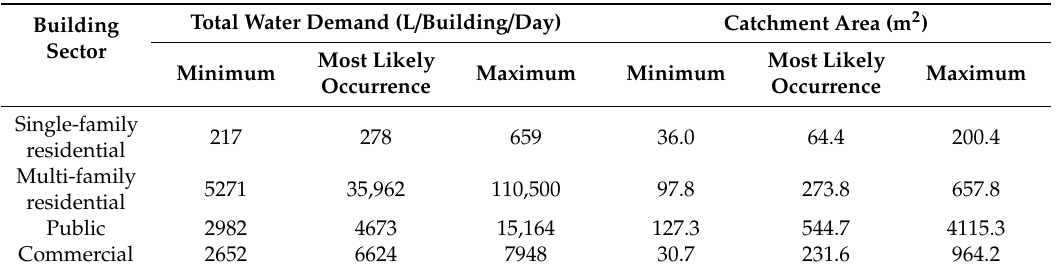
Table 3. Total daily water demands and catchment areas for each